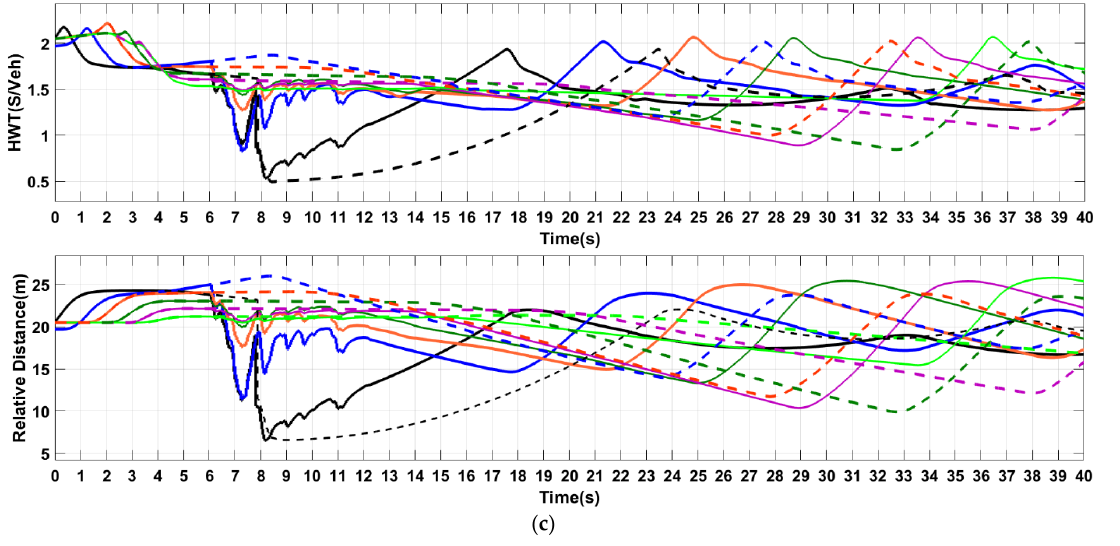
Figure 14. Simulation curve of CAVF fleet and CACCNF fleet in scenario 3: ( a ) CAVF fleet — HWT following distance speed; ( b ) CACCNF fleet — HWT following distance speed; ( c ) comparison of follow-up distance and HWT between CANF team and CACCNF team.